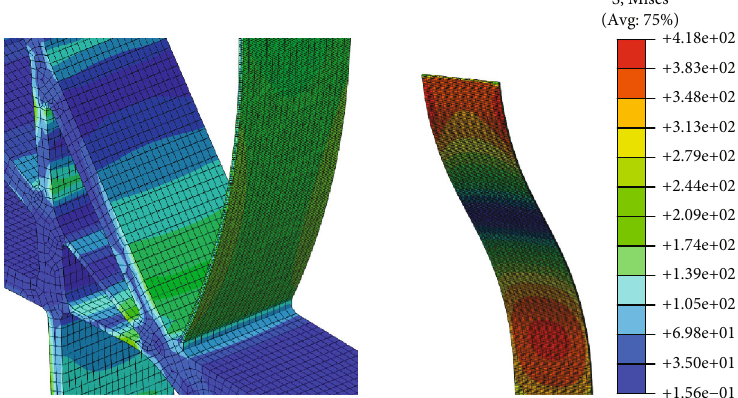
Figure 15: Tip rib: detail of the most stressed regions under limit loads. Table 5: Safety margins for the structural veri fi cation of the ribs. Root rib Tip rib Limit loads 0.74